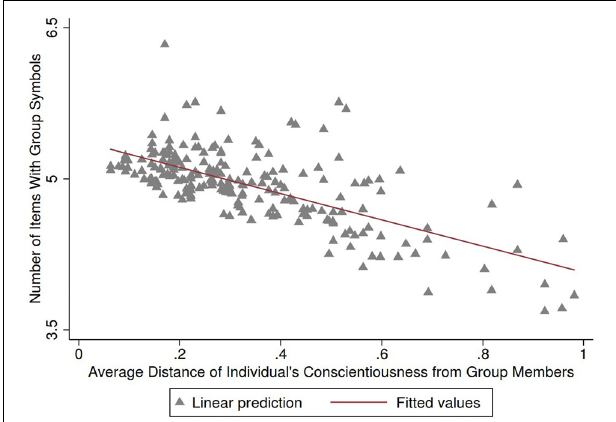
FIGURE 3 | Association of variation in group conscientiousness and group performance/identification. Personality measured as individual’s distances to other group members taking into account heteroscedasticity. Group performance/identification was measured as number of group items adopted. Regression controlling for gender and individual’s own personality traits.